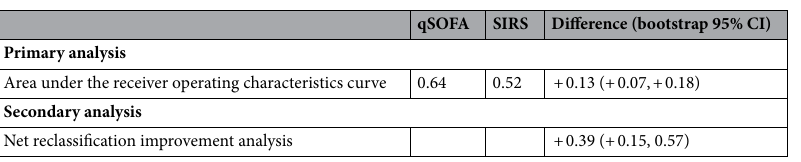
Table 2. Comparison between qSOFA and SIRS criteria prognostic accuracy in predicting in-hospital mortality. Bootstrap estimation repeated 20,000 times (800 times per imputed dataset), to compute